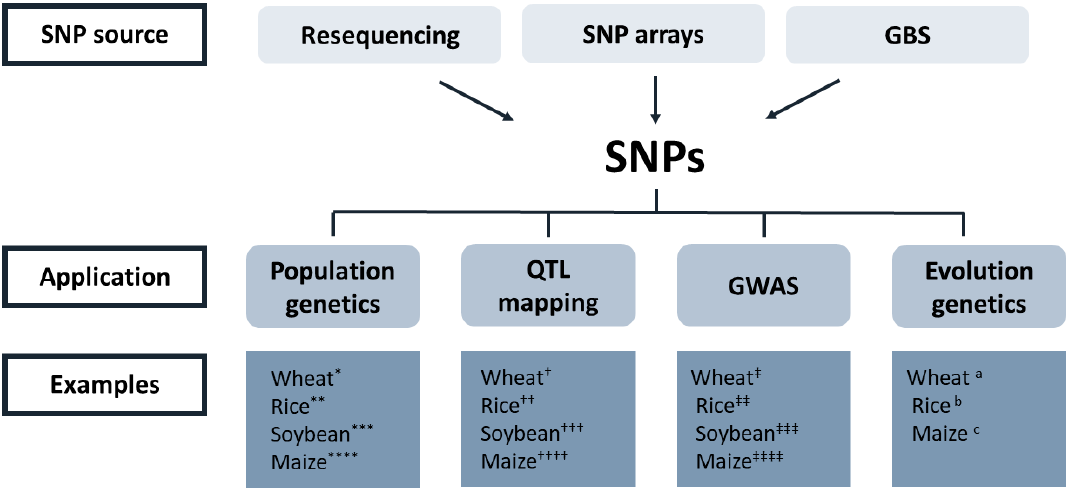
Figure 2. Applications of single nucleotide polymorphisms (SNPs) in plant sciences. Citations are as follows: ∗ [47,48] , ∗∗ [49] , ∗∗∗ [50,51] , ∗∗∗∗ [52–54] , † [55–57] , †† [58–60] , ††† [50,61] , †††† [62–64] , ‡ [65,66] , ‡‡ [67–69] , ‡‡‡ [70,71] , ‡‡‡‡ [62,72] , a [73–75] , b [76,77] , c [78,79] .